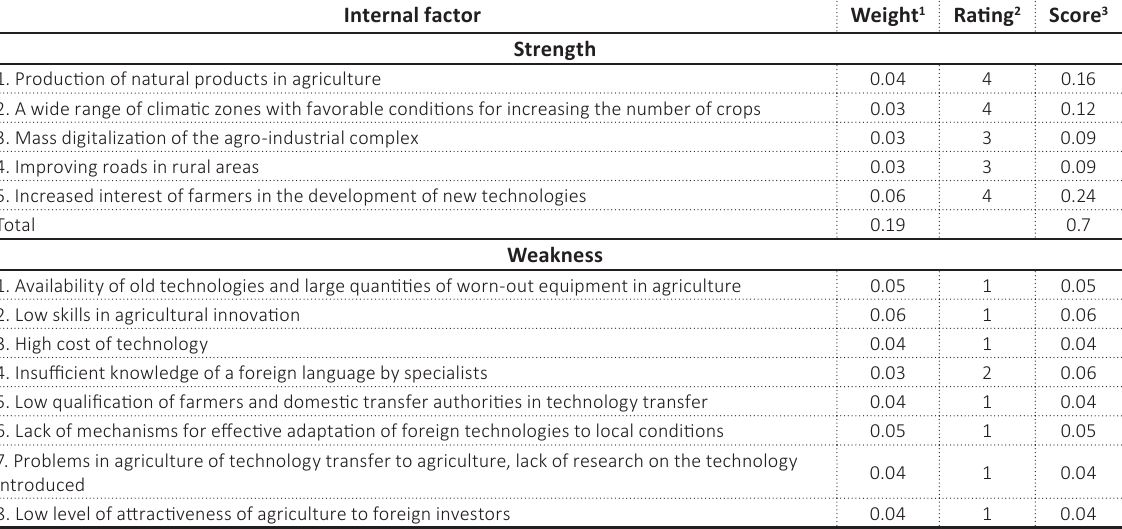
Table 2. Analysis of the internal environment of technology transfer in the agricultural sector of